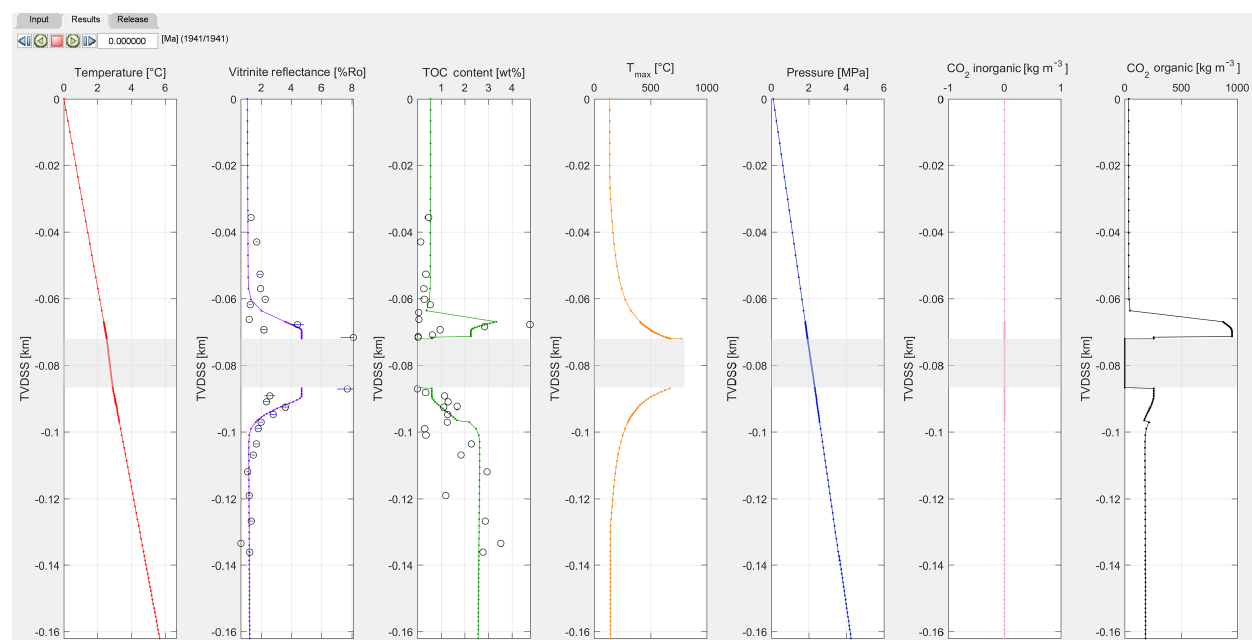
Figure 9. Results tab at the end of the simulation time for KL1/78 shows a good match to present-day TOC and VR